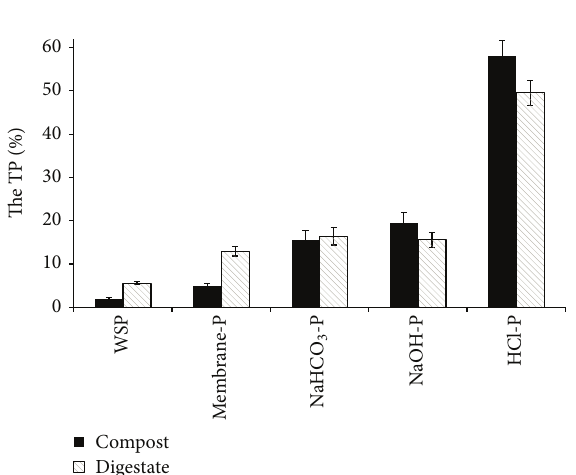
Figure 1: Fractionation of P in compost and digestate.